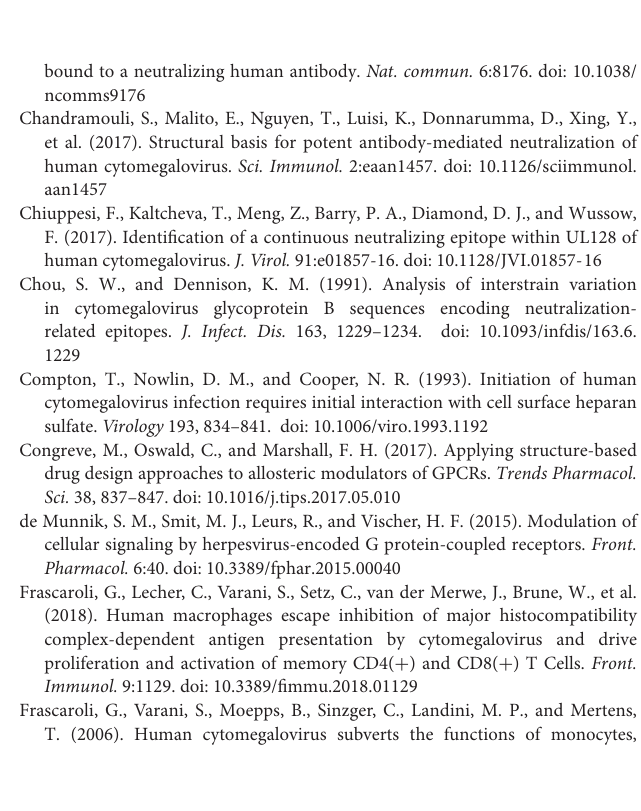
FIGURE S1 | Sequence alignment of gN and gO proteins. Amino acids different from the reference HCMV strain (Merlin) are highlighted in red. Thick lines inside the aligned sequences represent 100 amino acids. ( a ) Protein alignment of gN. ( b ) Protein alignment of gO. FIGURE S2 | Labeled gB phylogenic tree. Phylogenic analysis of the amino acid sequences by Maximum Likelihood method for gB with name of the strains. Bootstrap values equal or higher than 70% are shown. FIGURE S3 | Labeled pentamer phylogenic tree. Phylogenic analysis of the amino acid sequences by Maximum Likelihood method for the pentamer with name of the strains. Bootstrap values equal or higher than 70% are shown. TABLE S1 | HCMV strains used for the study. DATA S1 | gB alignment file in fasta